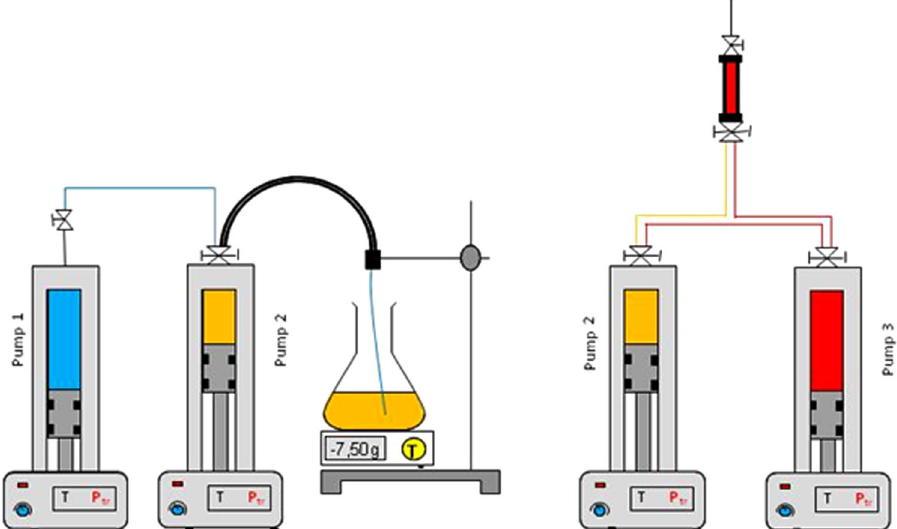
Fig. 3 Sketches of the protocol for the liquid mixture preparation (left fi gure) and gas – liquid mixtures (right fi gure). This fi gure has been created by